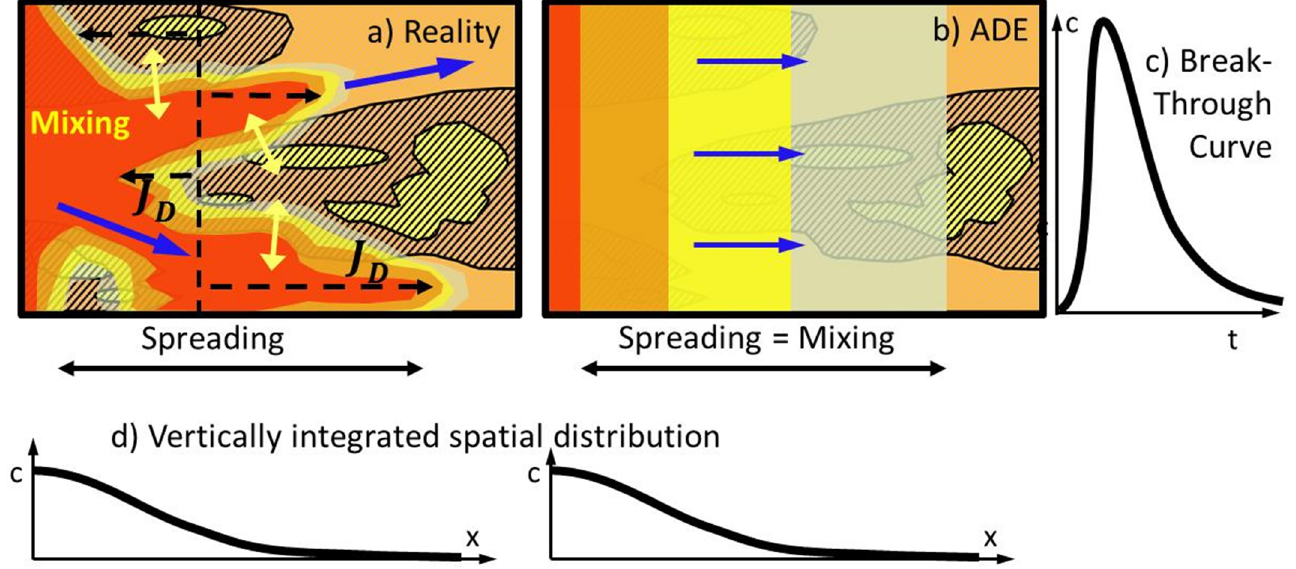
Figure 12. Transport through heterogeneous media ( a ) is characterized by mean advection, dispersion (black dashed arrows, J D , in ( a ), which spreads fronts, and molecular diffusion (double yellow arrows), which causes mixing. The ADE ( b ) fails to distinguish between spreading and mixing, thus overestimating the rates of mixing and fast reactions, even if the solute spatial distribution (vertically integrated during sampling, d ) and BTCs ( c ) look fine.